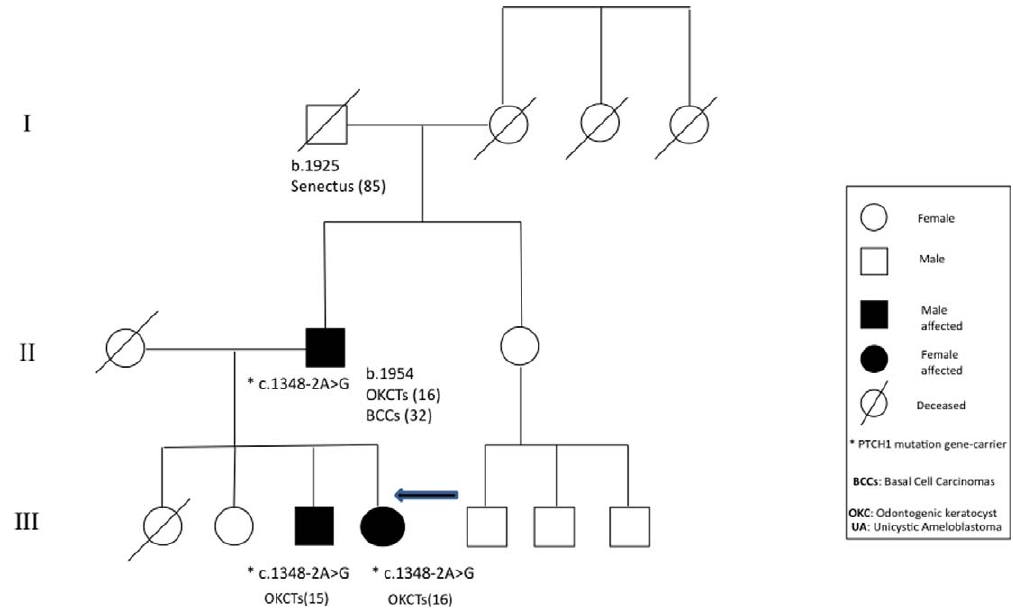
Figure 3. Genealogic tree of NBCCs family without the diagnosis of BCCs (Patient n.11 of table 2).